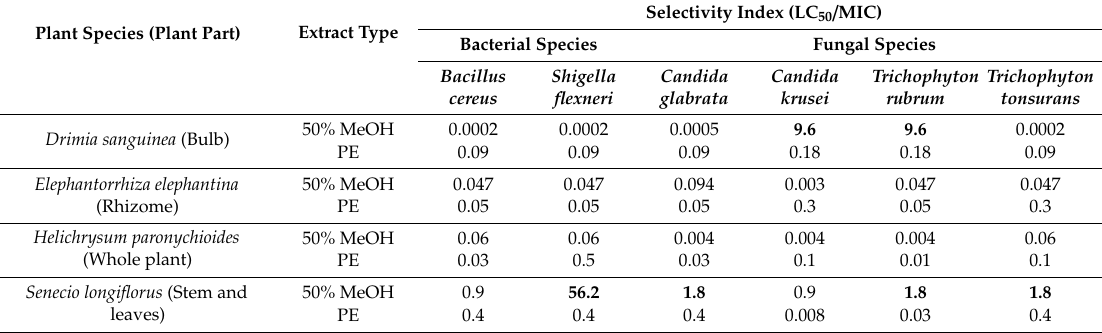
Table 4. Selectivity index of extracts from four plants used by Batswana traditional health practitioners to treat skin diseases. The LC 50 ( µ g / mL) was converted to same unit (mg / mL) as the minimum inhibitory concentration (MIC). MeOH = methanol, PE = petroleum